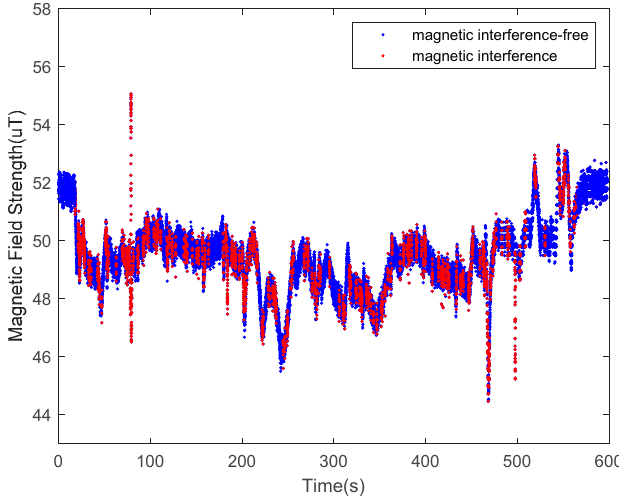
Figure 10. Magnetic data classification in outdoor pedestrian inertial navigation.